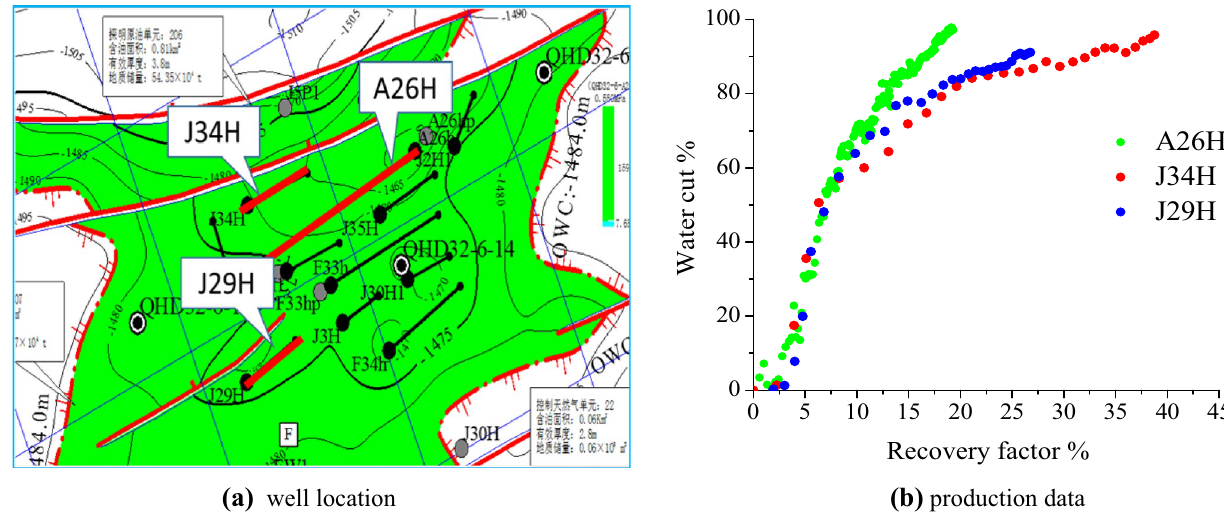
Fig. 5 The well location map and relation curve between water cut and recovery factor of